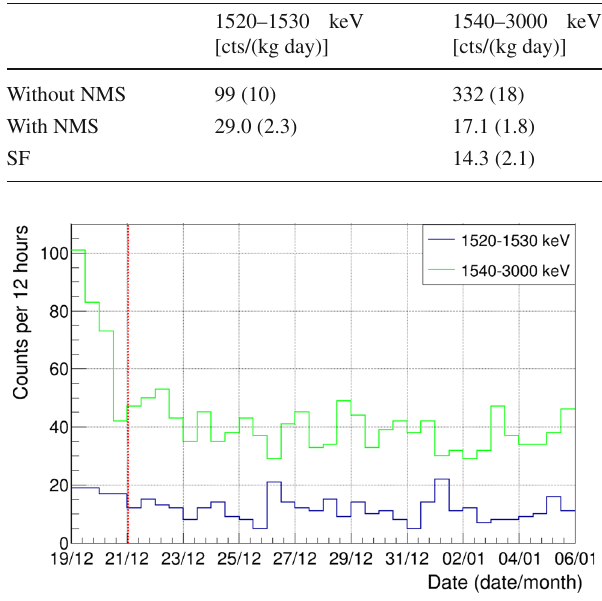
Fig. 10 Number of counts in the energy region 1520–1530 keV (blue) and 1540–3000 keV (green) in time for measurements of the detector without NMS in LArGe. The vertical red line indicates a period of the first 2 days which is not taken into account in the calculations